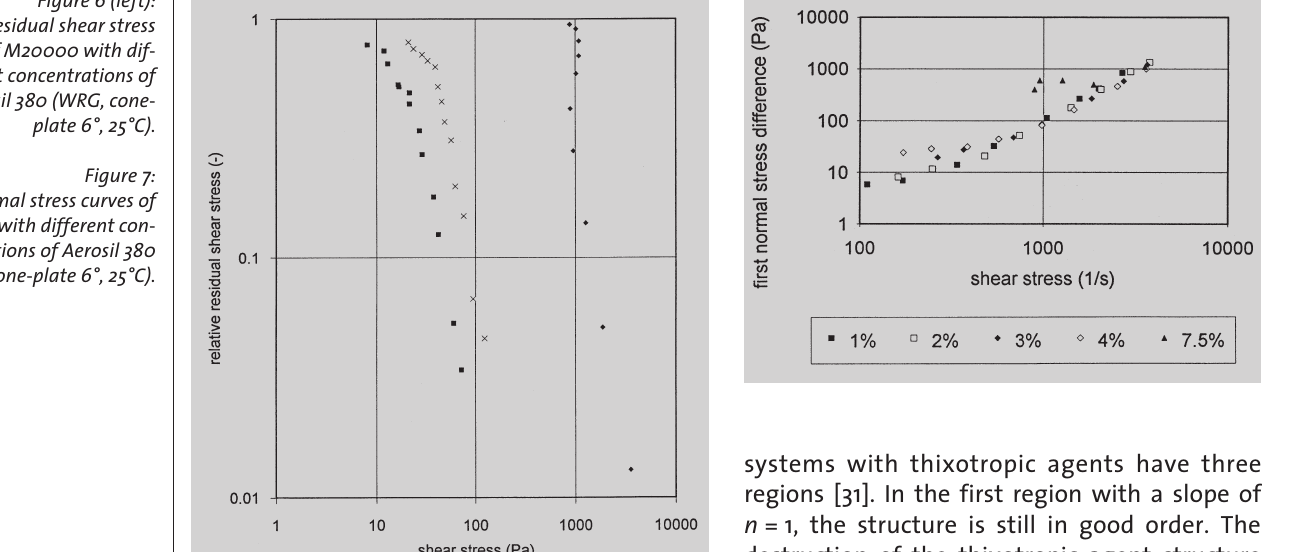
Figure 6 (left): Relative residual shear stress curves of M20000 with dif- ferent concentrations of Aerosil 380 (WRG, cone- plate 6°, 25°C). Figure 7: Normal stress curves of M20000 with different con- centrations of Aerosil 380 (WRG, cone-plate 6°,